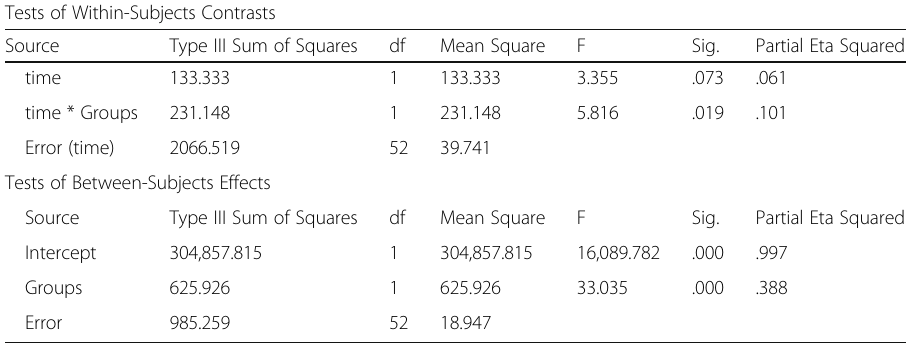
Table 8 Results of mixed-ANOVA on MRQ before and after treatment with time and group factors Tests of Within-Subjects